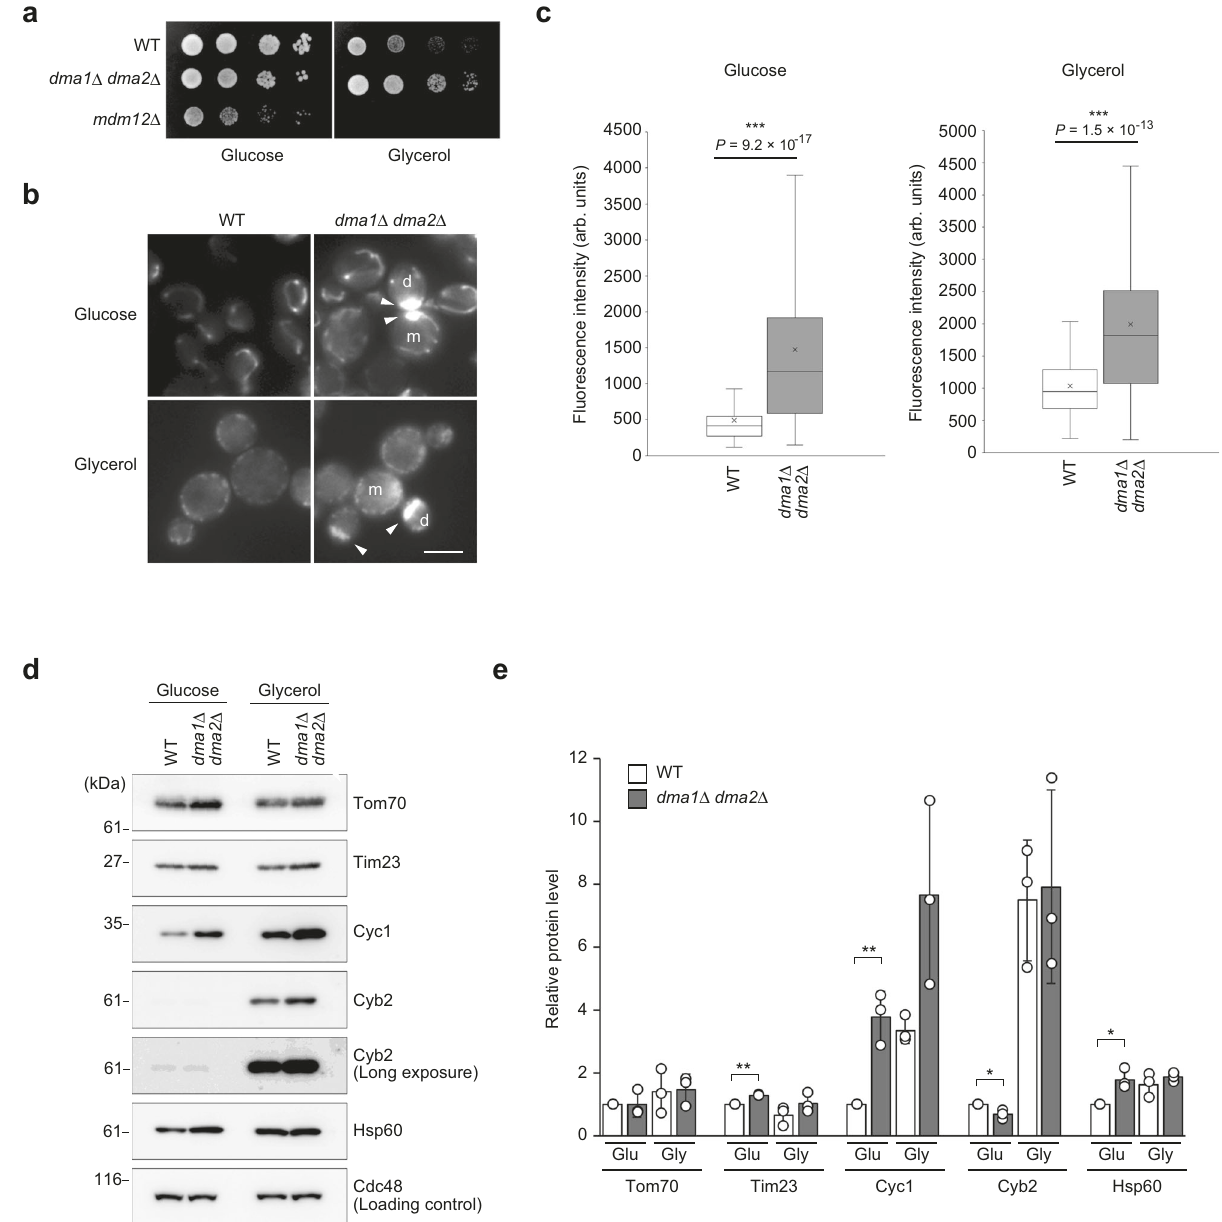
Fig. 7 Mitochondria in dma1 Δ dma2 Δ cells have elevated respiratory activity. a W303-1a (WT), YTK5416 ( dma1 Δ dma2 Δ ), and YTK5433 ( mdm12 Δ ) cells were grown to log phase; the cell density of each suspension culture was adjusted to A 600 = 0.5 and serially diluted to 1:10, and spotted on YPD (Glucose) or YPGlycerol (Glycerol) plate in which glycerol was used as the carbon source instead of glucose, and incubated at 30 °C for 48 h. b W303-1a (WT) and YTK5416 ( dma1 Δ dma2 Δ ) cells were grown to log phase in a synthetic complete medium (either glucose or glycerol was used as the carbon source), loaded with 50 nM TMRM for 1 h, and observed by fl uorescence microscopy. Arrowhead, TMRM signal from stacked mitochondria. m and d, mother and daughter cells, respectively. c Intensity of TMRM signal. Imaging data from ( b ) were used for the analysis. The box covers the region from